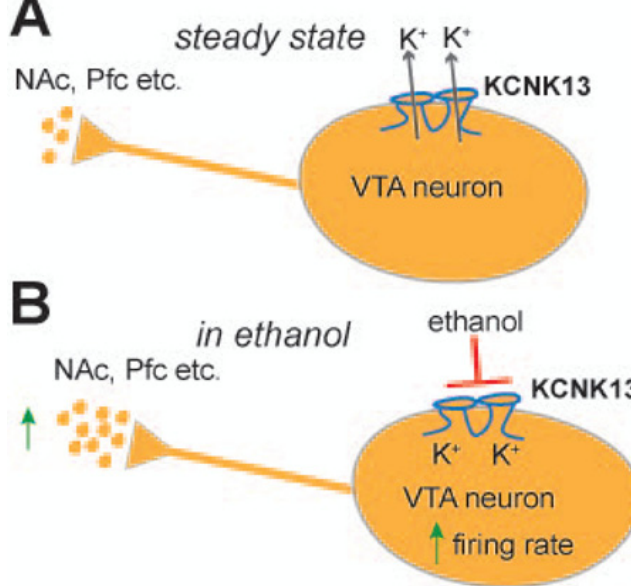
Figure 1. A schematic showing the steady state of VTA neurons ( A ) and how acute administration of ethanol stimulates VTA neurons by inhibiting KCNK13 ( B ); this molecule can modulate both VTA neuronal activity and binge drinking. KCNK13 is expressed in dopamine and non-dopamine neurons in the VTA. Kcnk13 gene expression is upregulated by acute alcohol consumption (Reproduced with permission from [26]).